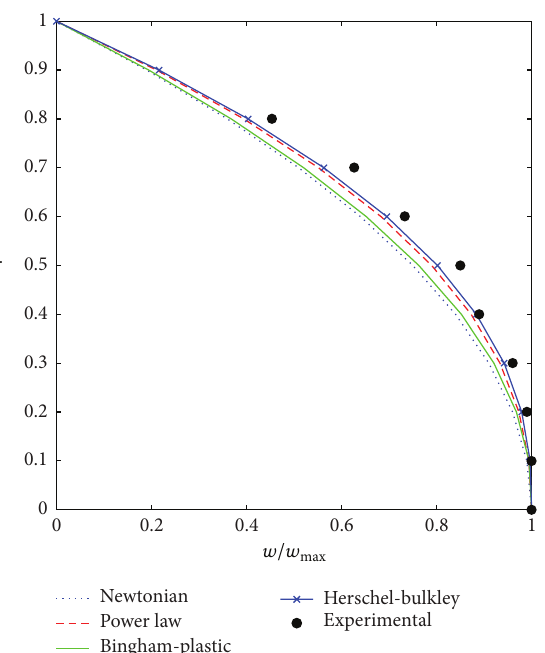
Figure 3: Comparison of velocity profiles for various fluids with experimental results.